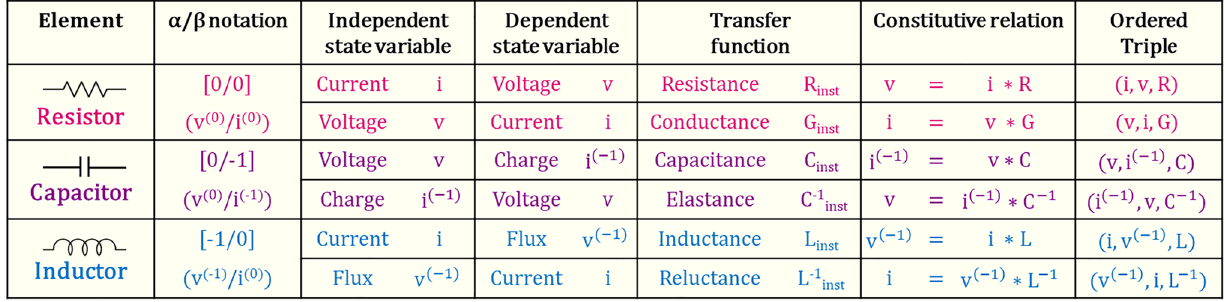
Table 1. Generalized Ohm’s law for the traditional fundamental circuit elements. Choice of the independent and dependent state variables and the associated transfer function in the generalized version of Ohm’s law to result in the three traditional fundamental circuit elements: a resistor, a capacitor, and an